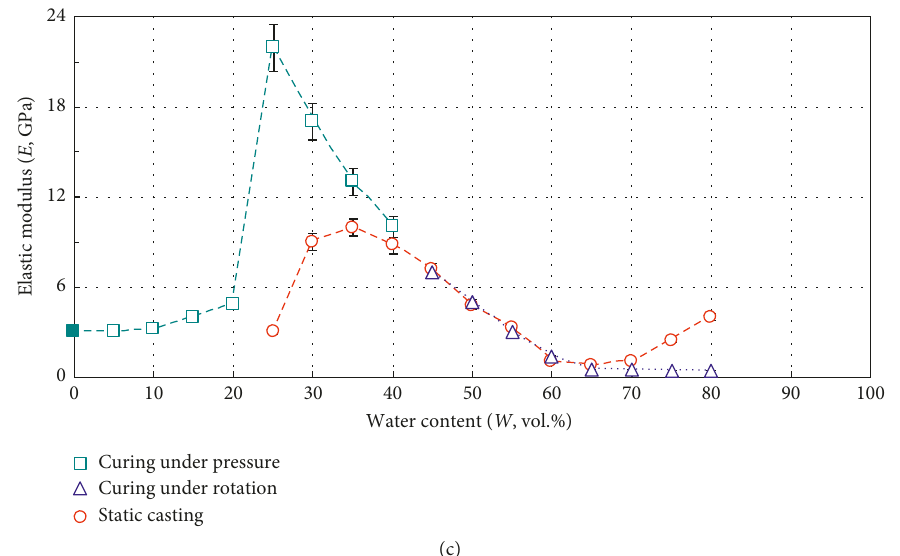
Figure 8: Effects of water content ( W vol.%) on samples (a) linear shrinkage after drying (LS, %), (b) total porosity (TP, %), and (c) flexural elastic modulus ( E GPa) after conventional static curing, curing under rotation, and curing under isostatic pressure (drying performed at 120 ° C for